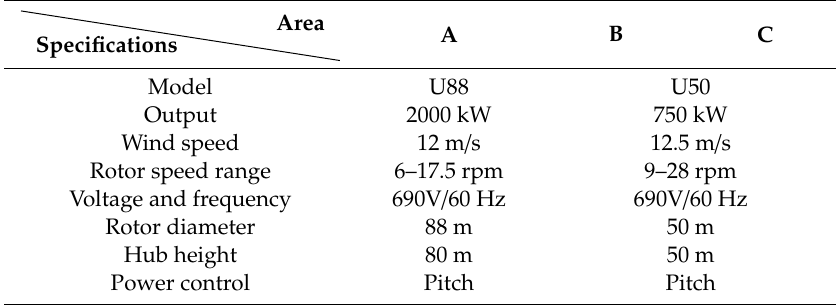
Table 2. Information about wind turbine generators in A, B, and C regions of Jeju Island.